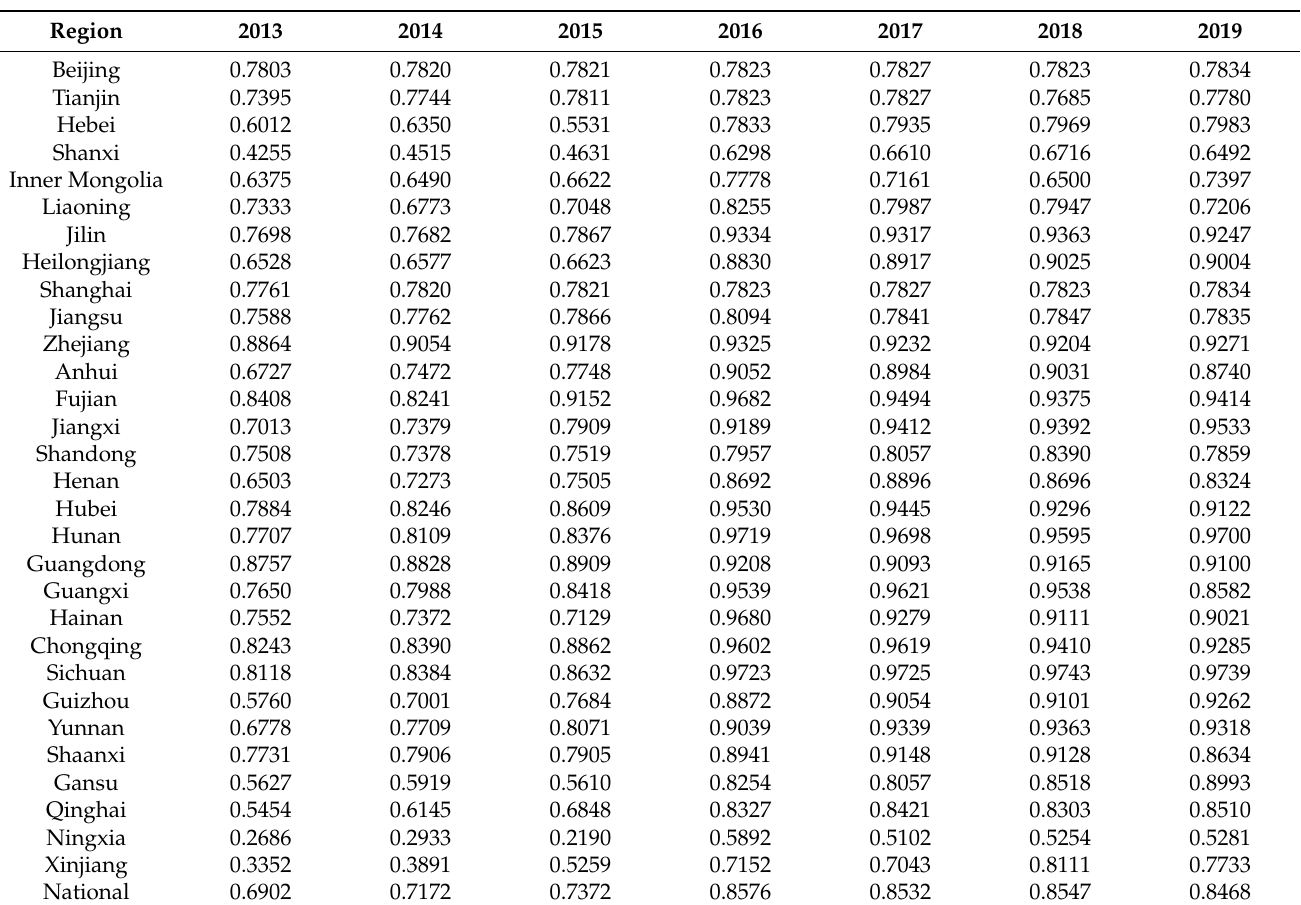
Table 5. P for 30 provinces,